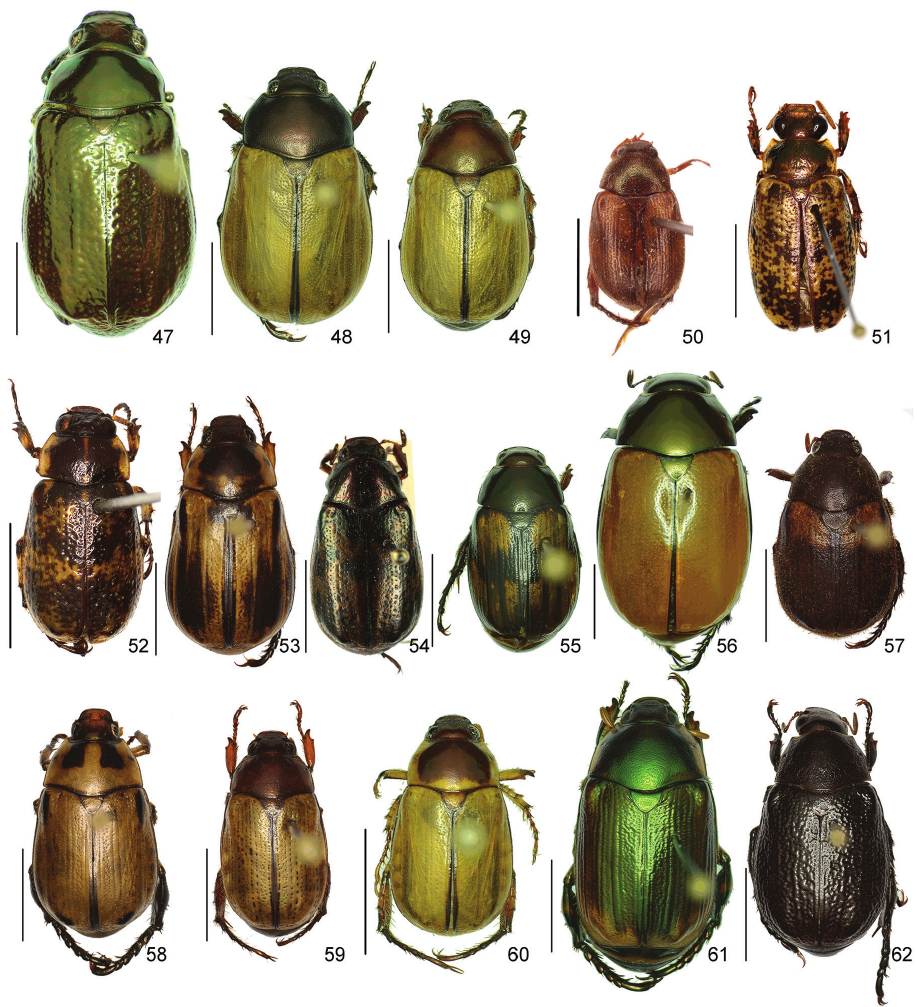
Figures 47–62. Habitus. 47 Anomala obovata (Cerro Chompipe, Heredia, MNCR) 48 A. ochrogastra (Estación Biológica Las Alturas, Puntarenas, MNCR) 49 A. ochroptera (La Maritza, Guanacaste, MNCR) 50 A. parvaeucoma (Estación Sirena, Puntarenas, MNCR) 51 A. perspicax (La Esperanza, Cartago CEUA) 52 A. piccolina (Estación Biológica Las Alturas, Puntarenas, MNCR) 53 A. pincelada (Finca Jenny, Gua- nacaste, MNCR) 54 A. polygona (Escazu, Costa Rica, MNHUB) 55 A. popayana (Reserva Biológica Hitoy Cerere, Limón, MNCR) 56 A. praecellens (Orosilito, Guanacaste, CEUA) 57 A. pseudoeucoma (Estación Hitoy Cerere, Limón, MNCR) 58 A. quiche (Estación Maritza, Guanacaste, MNCR) 59 A. robiginosa (Zarcero, Alajuela, MNCR) 60 A. ruatana (Playa Naranjo, Guanacaste, MNCR) 61 A. semi- cincta (Estación Cabro Muco, Guanacaste, CEUA) 62 A. semilla (Albergue Heliconias, Alajuela, CEUA). Scale bars: 5 mm. Fig. 62 from Filippini et al. (2014); Fig. 53 from Filippini et al. (2015b); Fig. 59 from Filippini et al. (2015c); Figs 51–52, 54 from Filippini et al. (2015d); Fig. 50 from Filippini et al.